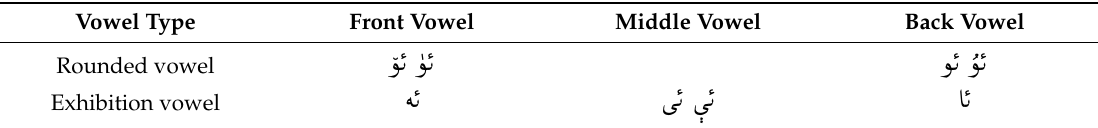
Table 4. Uyghur vowel classification.